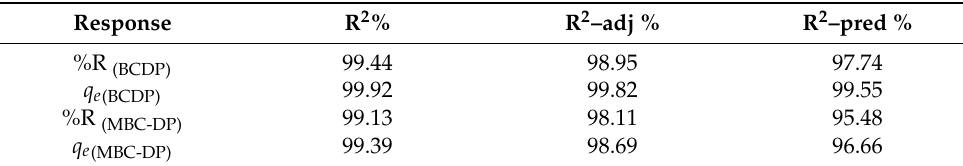
Table 4. Summaries of the regression